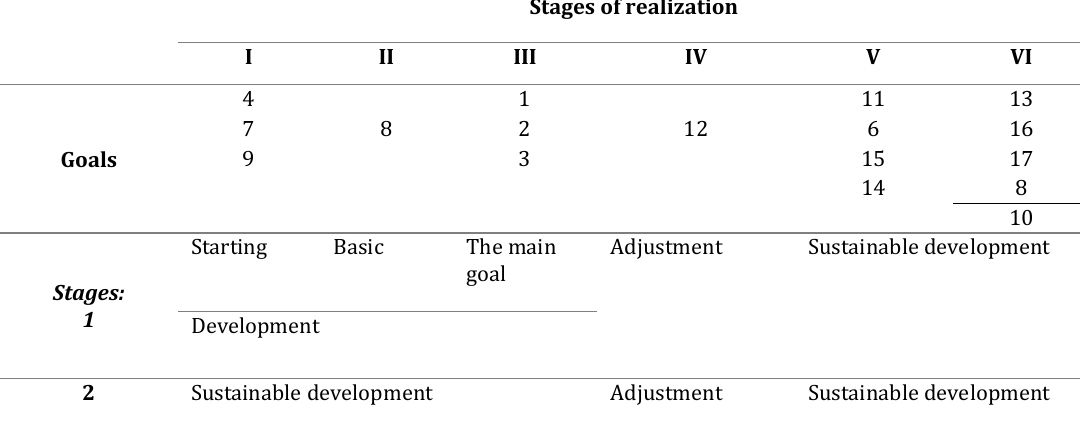
Table 3. Algorithm of the incipience of sustainable development in rural areas